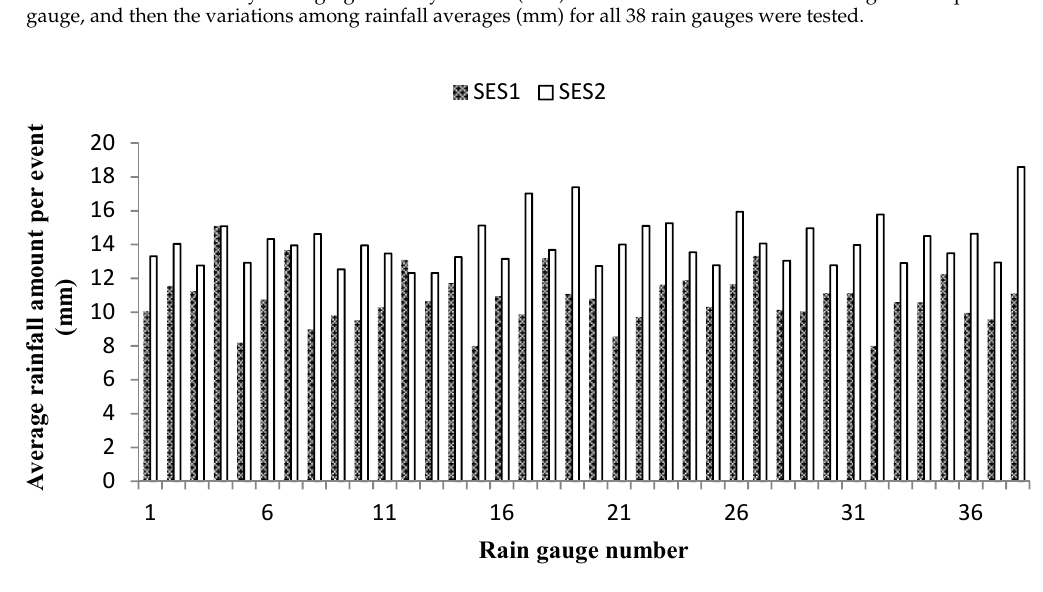
Figure 4. Average rainfall amounts per event for SES1 and SES2. Table 2. Probabilities of daily rainfall